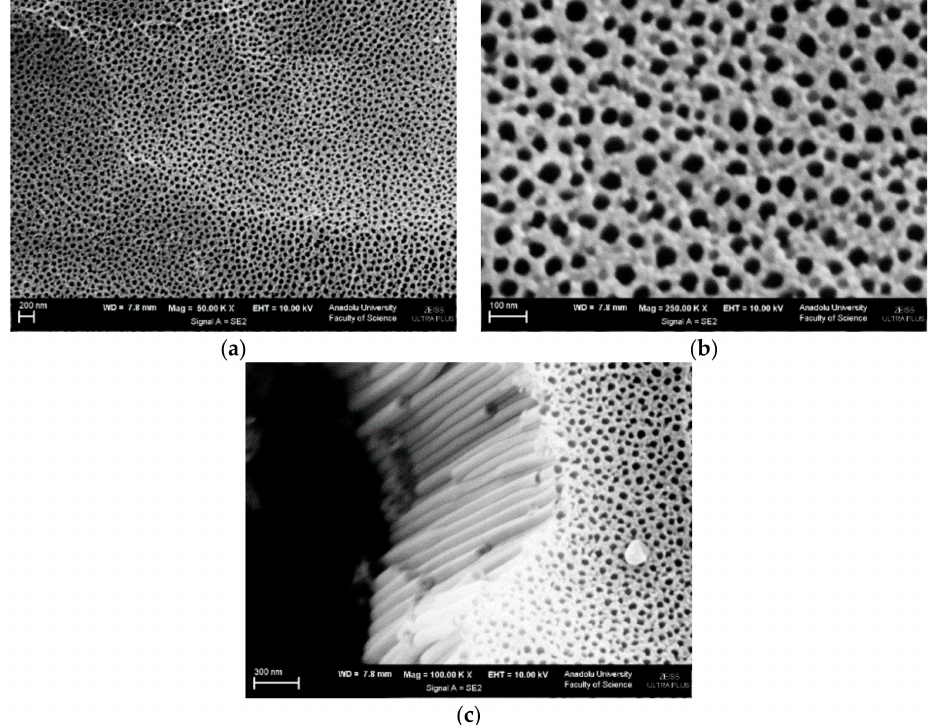
Figure 6. SEM image of Ti/TiO 2 NTEG-2h-500 photoanode: ( a ) top view (magnification: 50,000 × ), ( b ) top view (magnification: 250,000 × ) and ( c ) cross-section view (magnification: 100,000 ×